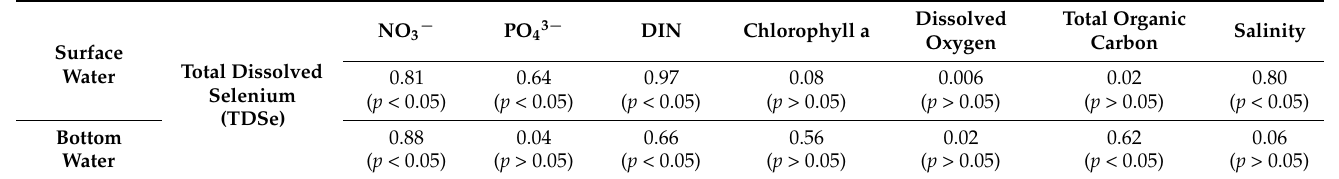
Table 3. Physical and chemical parameters correlation coefficient against total dissolved selenium in the surface and bottom water of Al-Arbaeen Lagoon ( n = 6